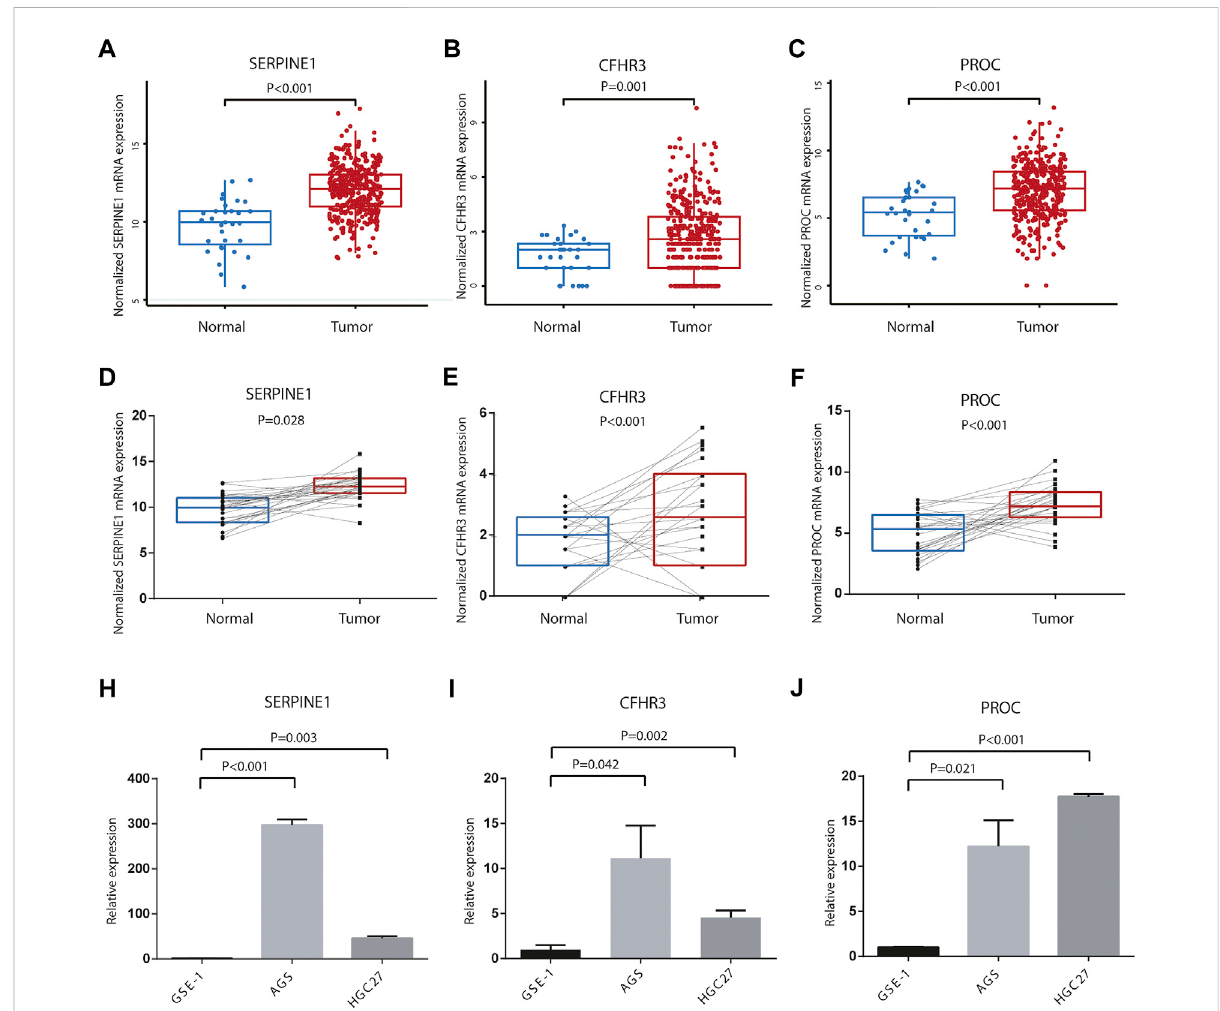
FIGURE 10 Differences of three-gene expression levels. (A) SERPINE1 , (B) CFHR3 , and (C) PROC mRNA expression levels were signi fi cantly different in the unpairedtumor-adjacentnormalTCGASTADsamples. (D) SERPINE1, (E) CFHR3,and (F) PROCmRNAexpressionlevelsweresigni fi